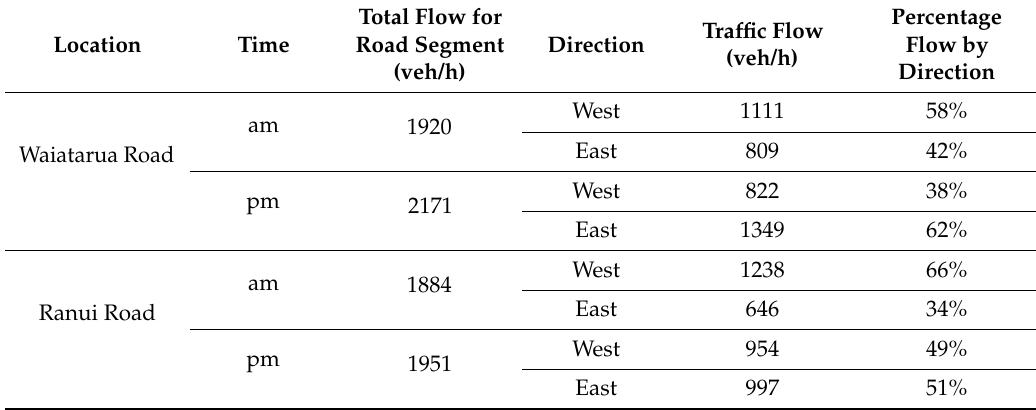
Table 1. Traffic volume by flow and direction along the main arterial road (Remuera Road) at